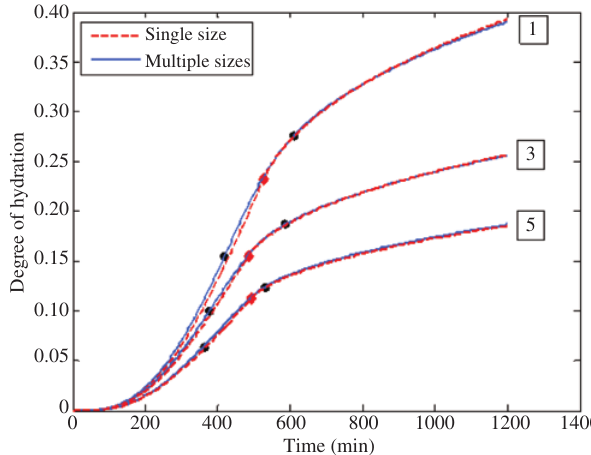
Figure 6 Comparison between model curves obtained with single particle size versus multiple particle sizes ( ♦ indicate transition points for single-particle model while • indicate the transition period for multiple-particle